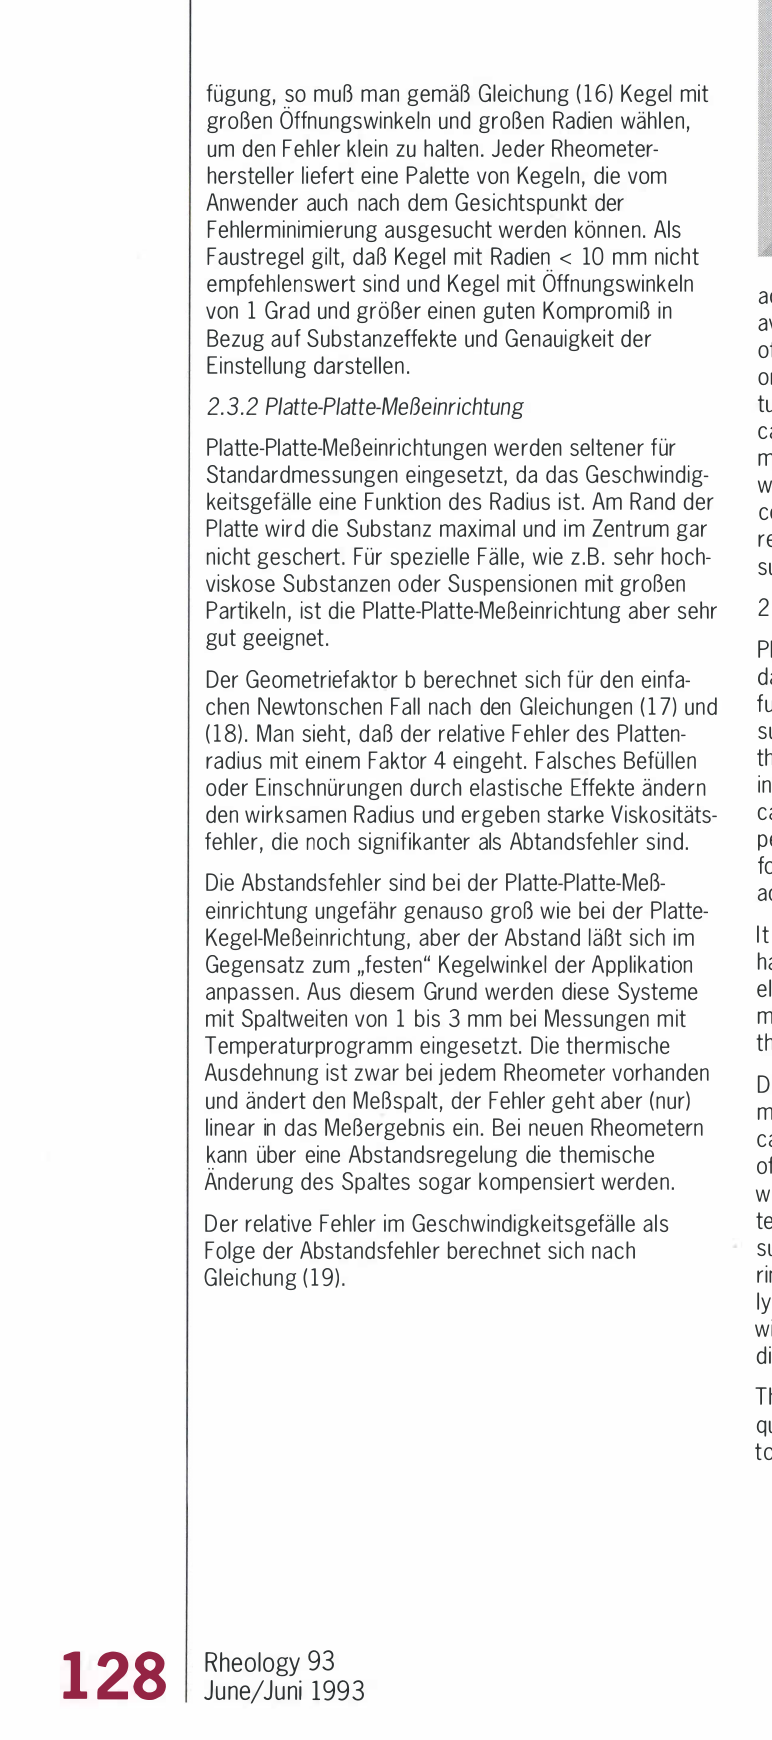
Fig. 5: Distance errors